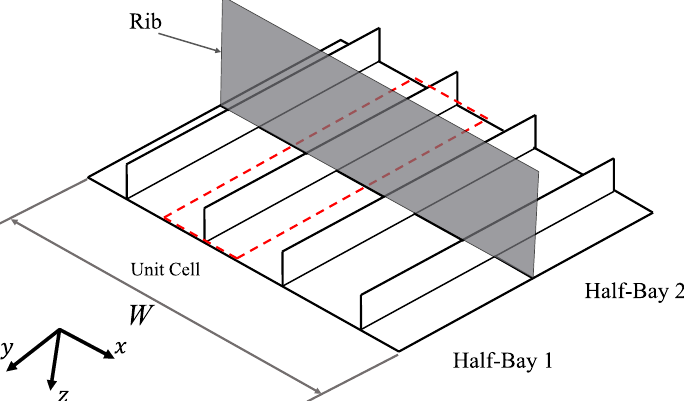
Figure 2. Schematic definition of the representative unit cell of the stiffened panel, depicted by the red dashed line. The width of the panel bay W is a given geometric